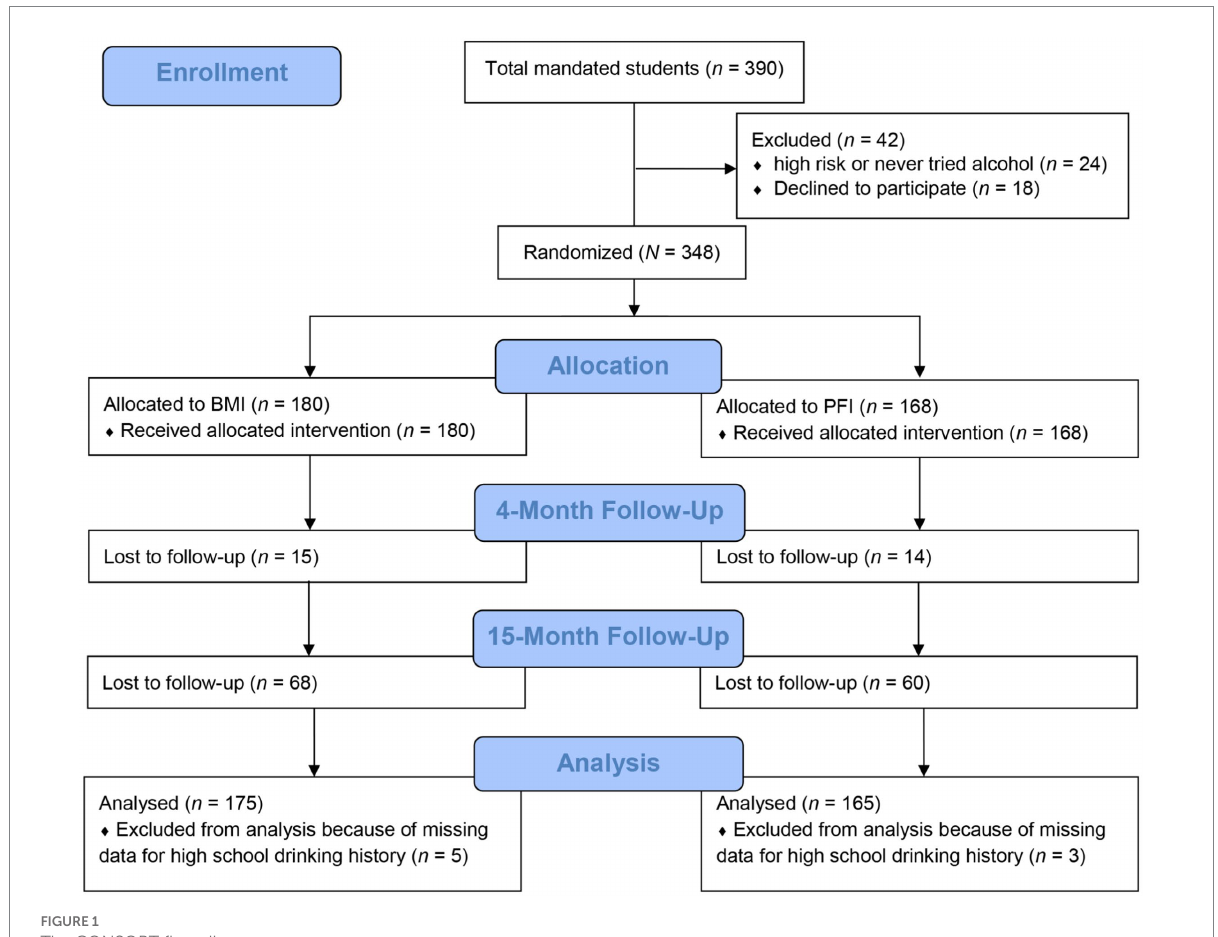
FIGURE 1 The CONSORT flow